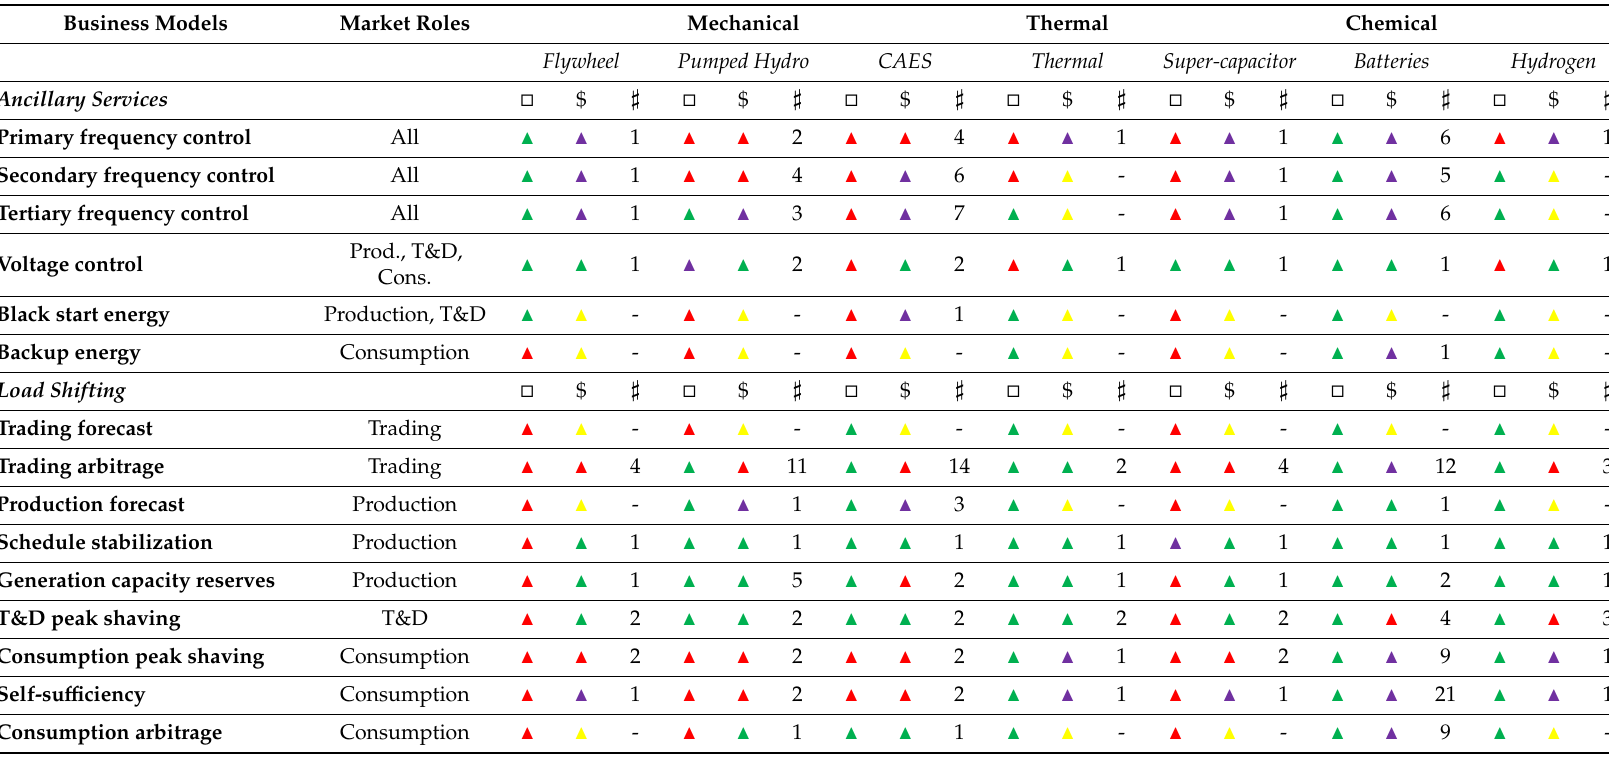
Table 21. Technology match and profitability of business models for energy storage. For each ESS, the first column matches the business models with storage technologies, the second column the profitability, and the third column the number of studies found that examine a match [253]. Business